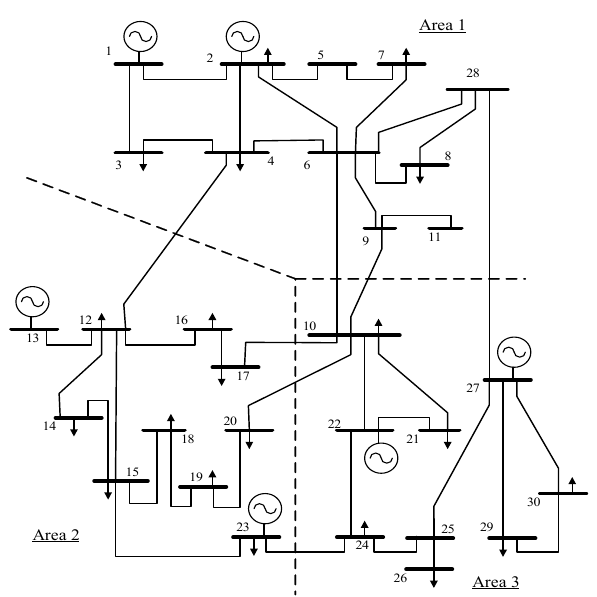
Figure 5. IEEE 30 ‐ bus system with three areas. Figure 5. IEEE 30-bus system with three areas.